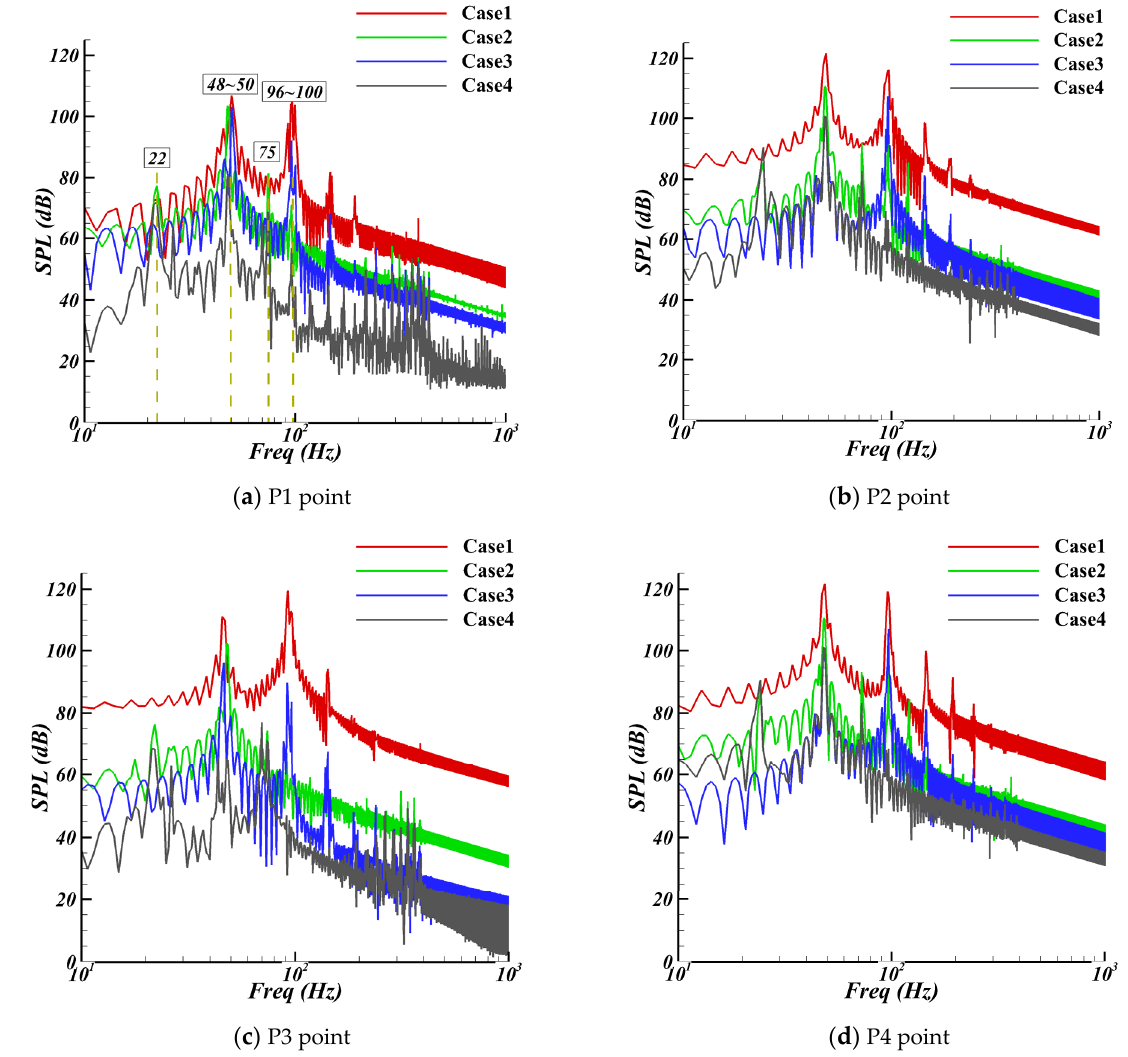
Figure 22. A comparison of the results of the sound pressure level spectrum curves at four monitoring points.